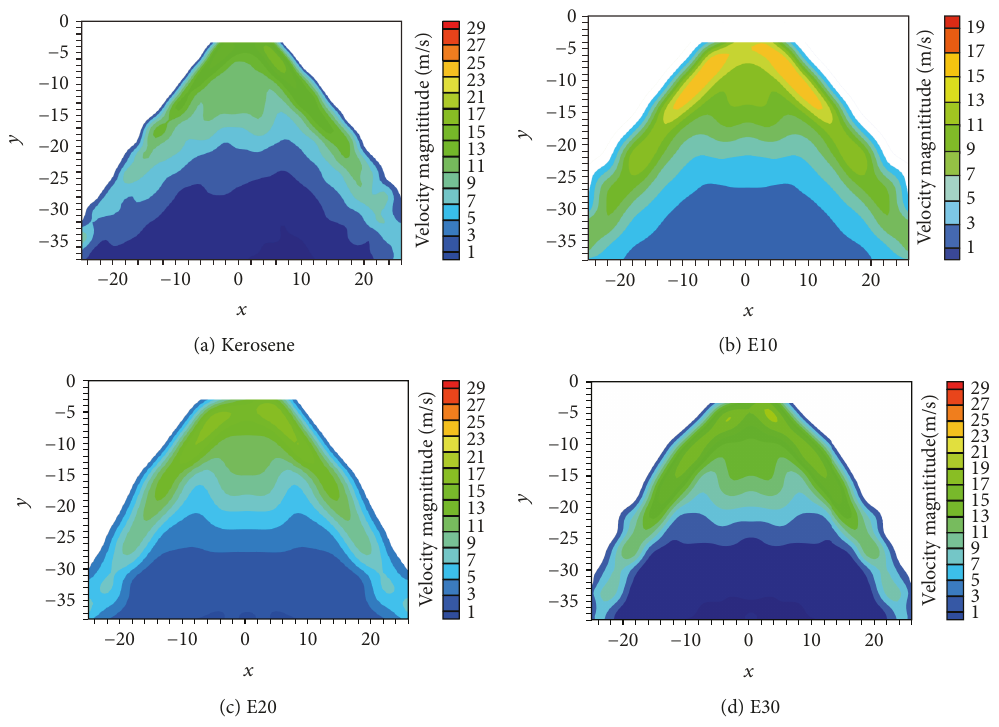
Figure 15: Blended fuel velocity magnitudes at